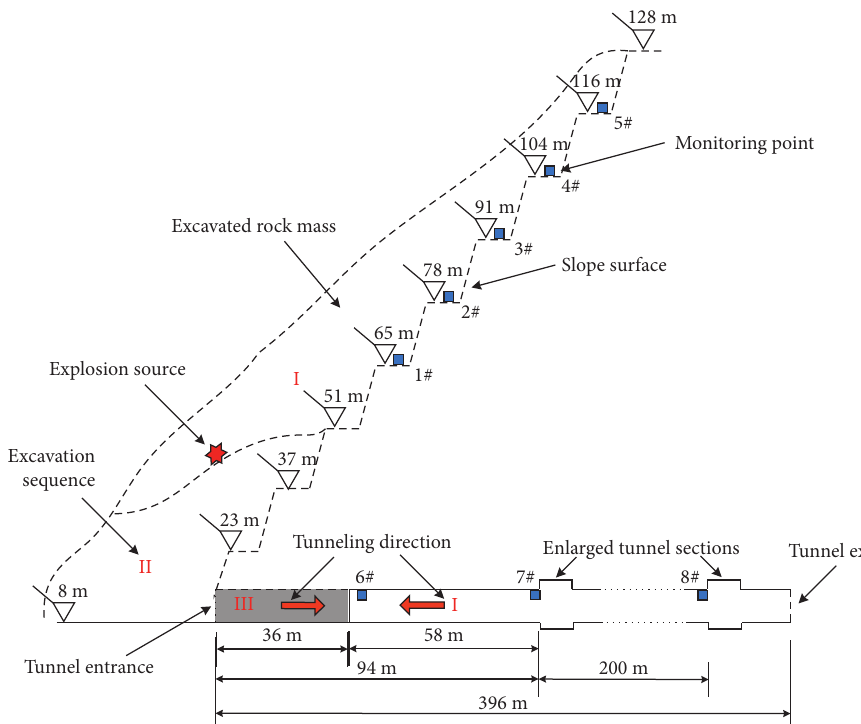
Figure 2: Schematic diagram of the spatial distribution of the upper slope and undercrossing tunnel. Table 1: Blast hole parameters in bench